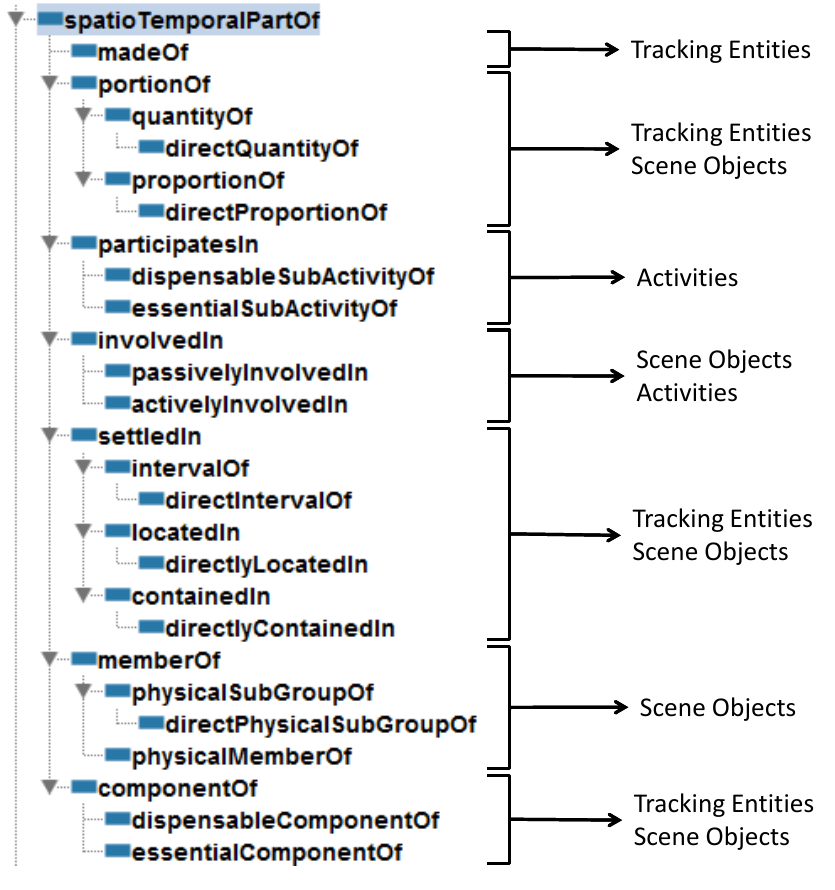
Figure 6. Spatio-temporal taxonomy with pattern representation.